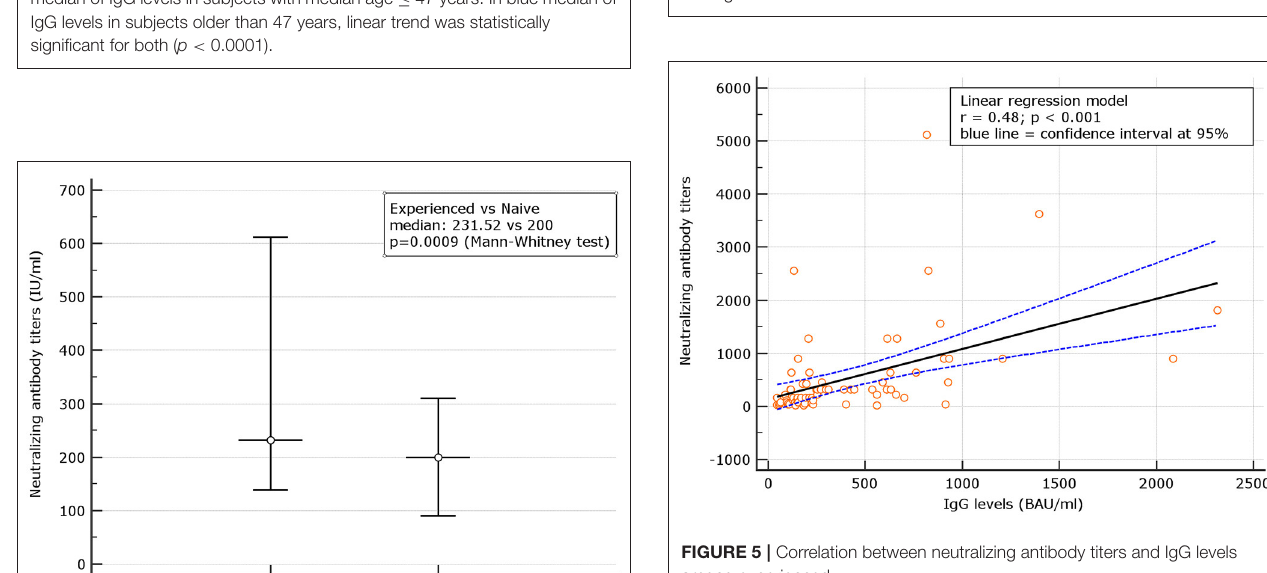
FIGURE 4 | Correlation between neutralizing antibody titers and IgG levels among naive.